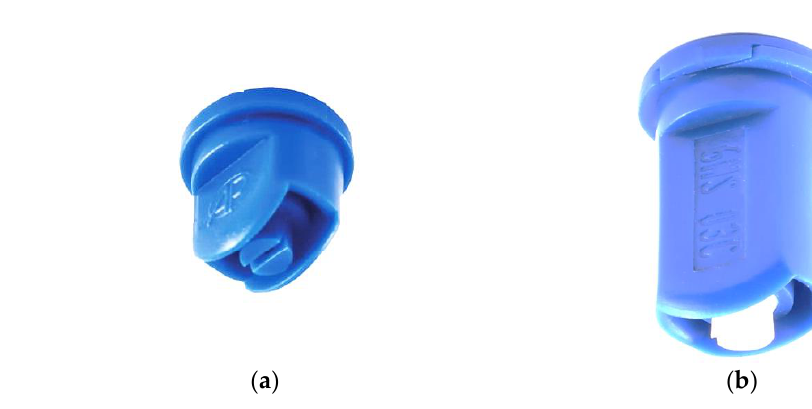
Figure 1. Nozzles tested: ( a ) AP12003; ( b ): 6MS03C.